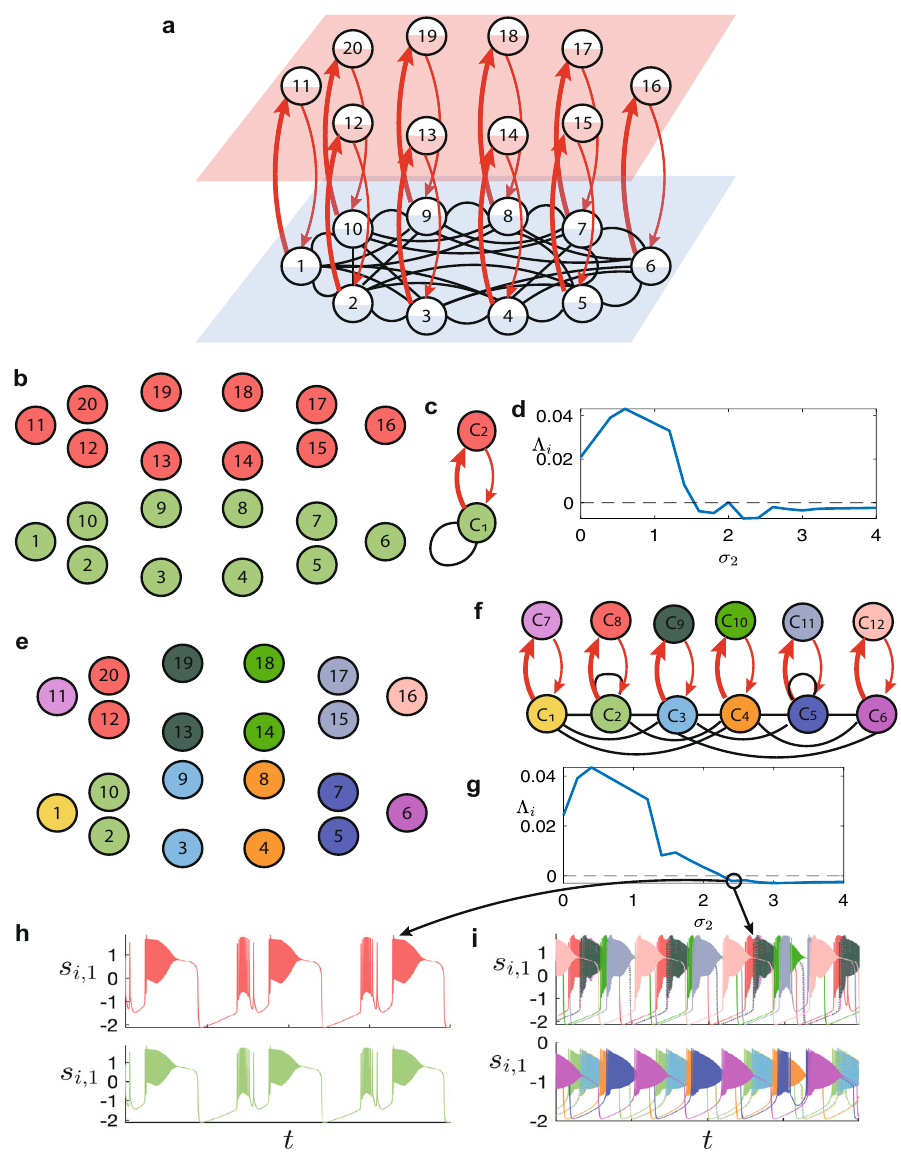
Fig. 7 Example adapted from ref. 29 . a Multilayer network with N = 20 nodes, L = 2 kinds of links, undirected intralayer and directed layer-to-layer connections. b Minimal balanced coloring/partition of the network, corresponding to Q = 2 clusters C 1 (green nodes, from 1 to 10) and C 2 (red nodes, from 11 to 20). c Corresponding quotient network. d MLEs Λ q corresponding to cluster C q ( q = 1, 2) vs. σ 2 . e Non-minimal balanced coloring/partition, corresponding to Q = 12 clusters, four of which are trivial (nodes 1, 6, 11, 16), while the other eight contain two nodes (2 – 10, 3 – 9, and so forth). f Corresponding quotient network. g MLEs Λ q corresponding to cluster C q ( q = 1, … , Q ) vs. σ 2 . h, i Time plots ( fi rst component of the synchronous cluster states s i for i = 1, … , Q ) evidencing the presence of multistability for σ 2 = 2.3: h corresponds to the minimal balanced partition of b (two distinct traces), while i corresponds to the non-minimal balanced partition of e (twelve distinct